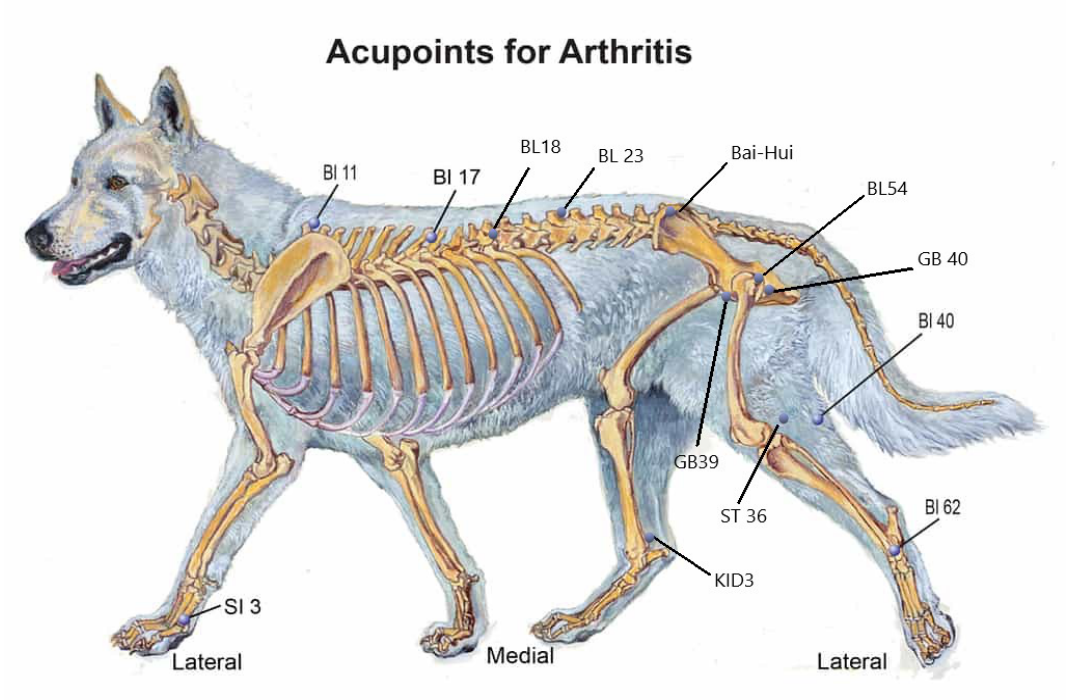
Figure 3 . Some of the acupoints used for treatment. Adapted after [6]